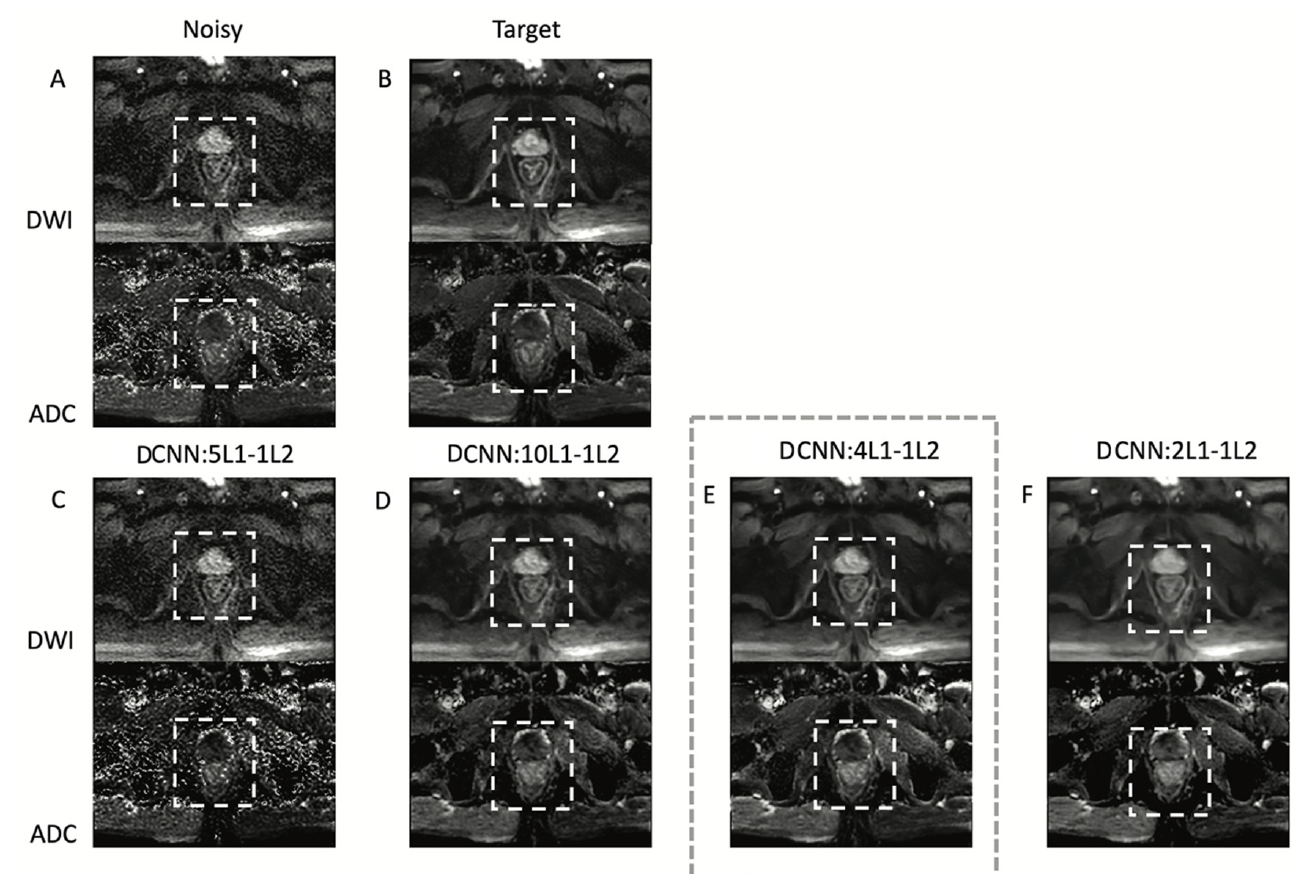
Figure 3. DCNN with different weighting factors for the L1–L2 combination loss function. ( A ) Noisy high b -value image reconstructed with NEX = 1 corresponding to an acquisition time of 22 s. ( B ) Target high b -value image with NEX = 16 corresponding to 370 s acquisition time. ( C – F ) denoised images acquired with NEX = 1 using 2, 4, 5, and 10 L1 weighting factors. The square with dashed lines shows the region of interest used to compute quantitative image quality metrics. A body radiologist selected the network with a weighting factor of 4 significantly as the one with the best balance between denoising and delineation of the rectal wall.